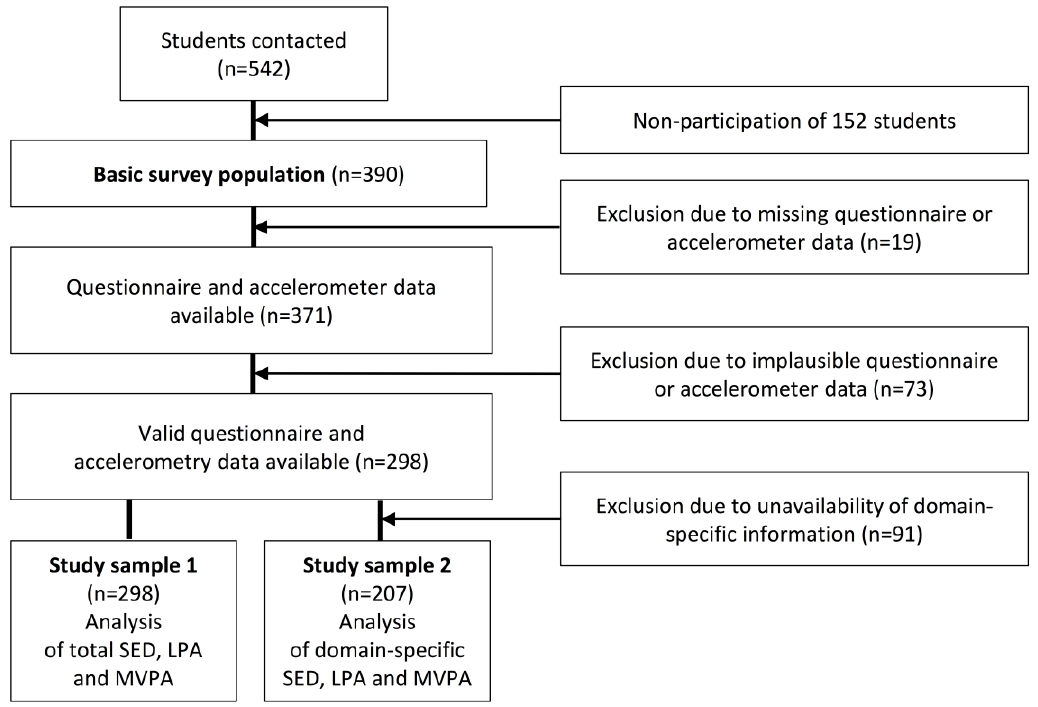
Figure 1. Number of included and excluded participants of the study population. SED = sedentary behaviour; LPA = light physical activity; MVPA = moderate-to-vigorous physical activity.